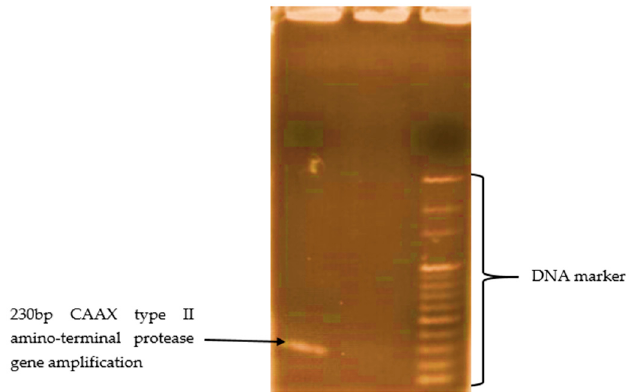
Figure 8. Amplified region of the CAAX type II amino-terminal protease gene using the set of primers CAAX F2 (5 ′‐ TGGACTTTTTGGCATCTTCC ‐ 3 ′ ) and CAAX R2 (5 ′‐ GGGTTGGTGGAATGAGTTTG ‐ 3 ′ ) developed in this study.